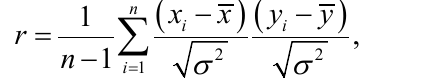
Correlation Matrix Figure 3. A matrix of plots showing the correlations between variables ETF, NDX